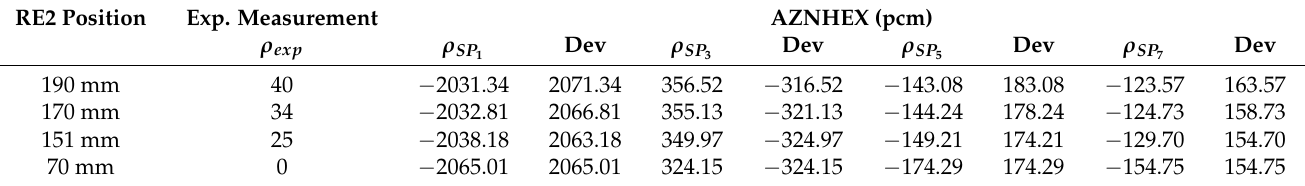
Table 5. Reactivity values and deviation in pcm from AZNHEX calculations and experimental data.